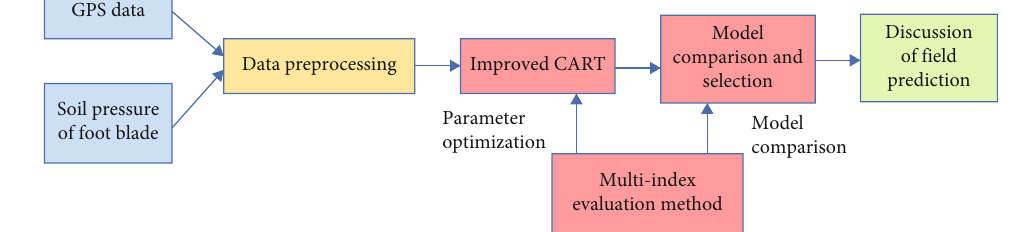
Figure 1: The fl ow chart of the soil pressure of foot blades prediction.